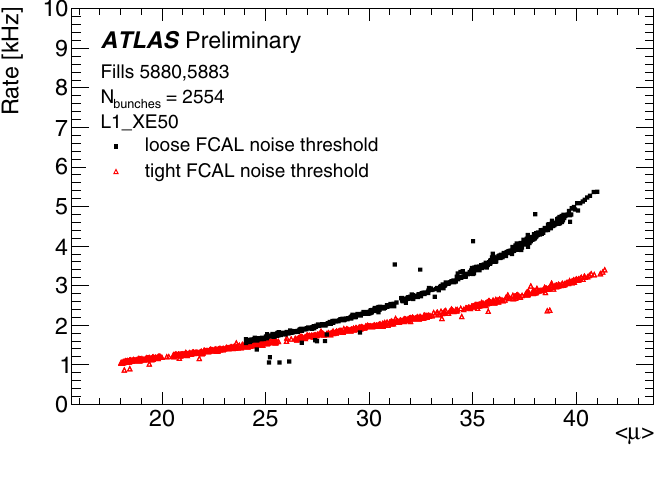
trigger as a function of the average interactions per bunch- Figure 1. Rate of the primary Level-1 E miss T crossing, with the loose (black) and tight (red) L1Calo filter coe ffi cients and noise cuts